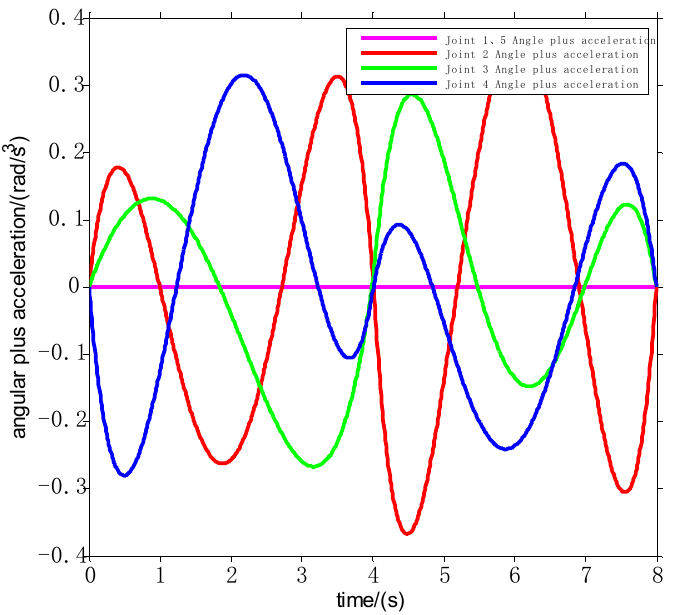
Figure 12. Spatial angular plus acceleration of the robot joint.